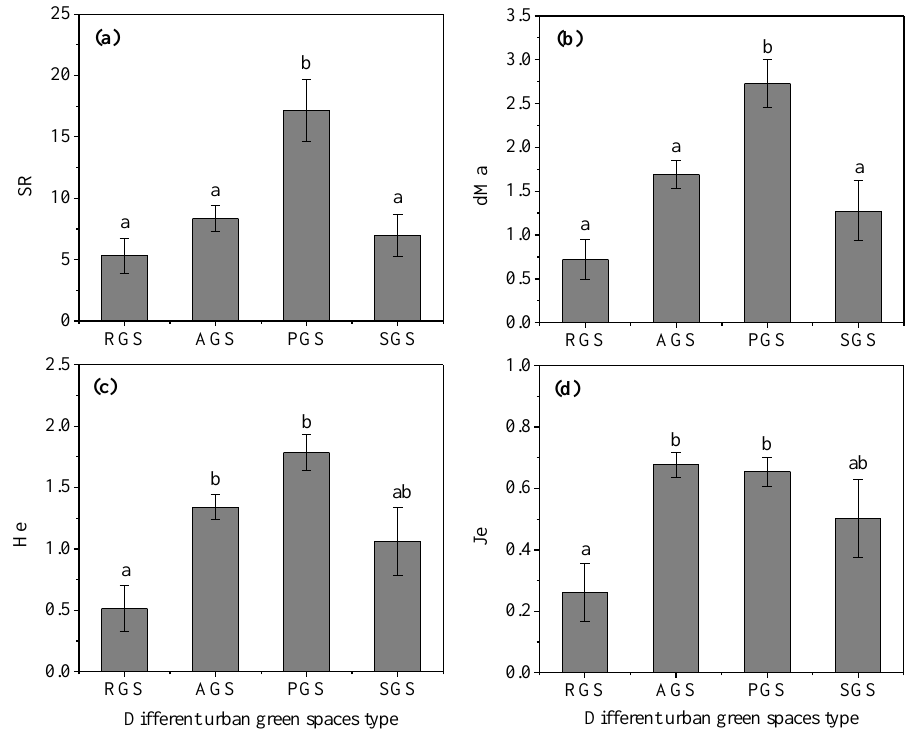
Figure 2. SR and diversity indexes of middle-aged trees among different types of green spaces in Changchun city. Note: Data in the figure are means ± standard errors; different lowercase letters indicate significant differences ( p < 0.05). ( a ) SR, species richness; ( b ) dMa, Margalef richness index; ( c ) H e , Shannon – Wiener index; ( d ) J e , evenness index. RGS, road green spaces; AGS, attached green spaces; PGS, park green spaces; SGS, square green spaces.